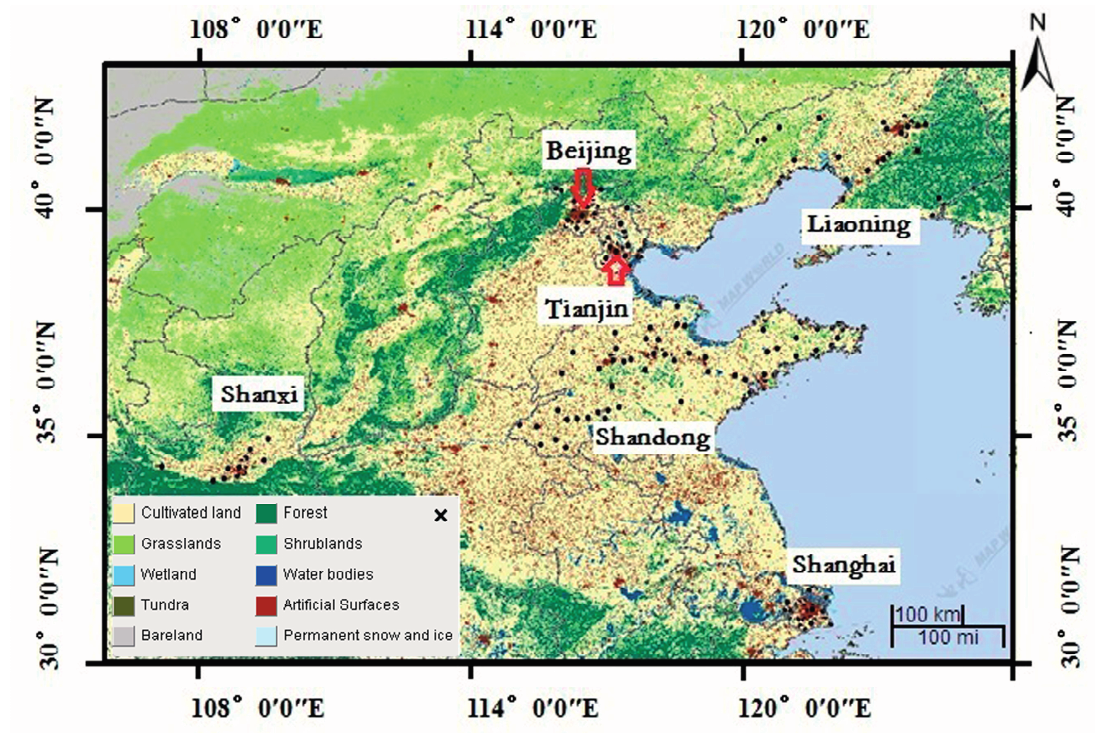
Figure 6. Distribution of geo-tagged web texts in the six study areas on GlobeLand30-2010.